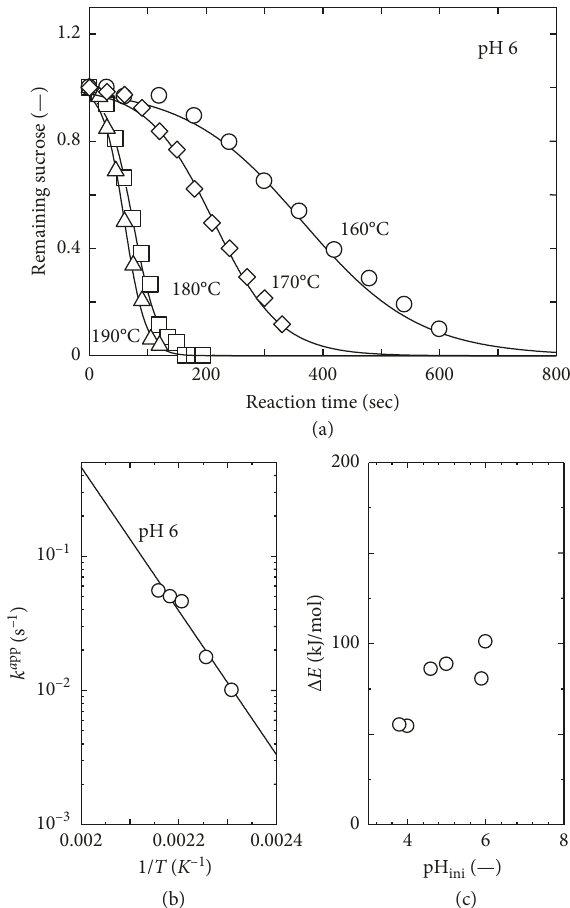
Figure 5: (a) Time course of sucrose decomposition at various temperatures. Arrhenius plot of the apparent rate constant ((b) pH 6) and (c) pH dependency of activation energy for sucrose